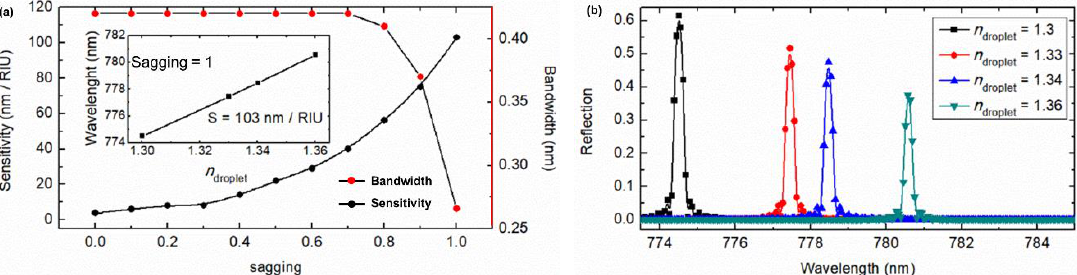
Figure 8. ( a ) Sensitivity and bandwidth dependence on sagging of the droplet. The inset shows the Bragg wavelength vs. n droplet ; ( b ) Wavelength shift for the optofluidic filter system with sagging = 1.